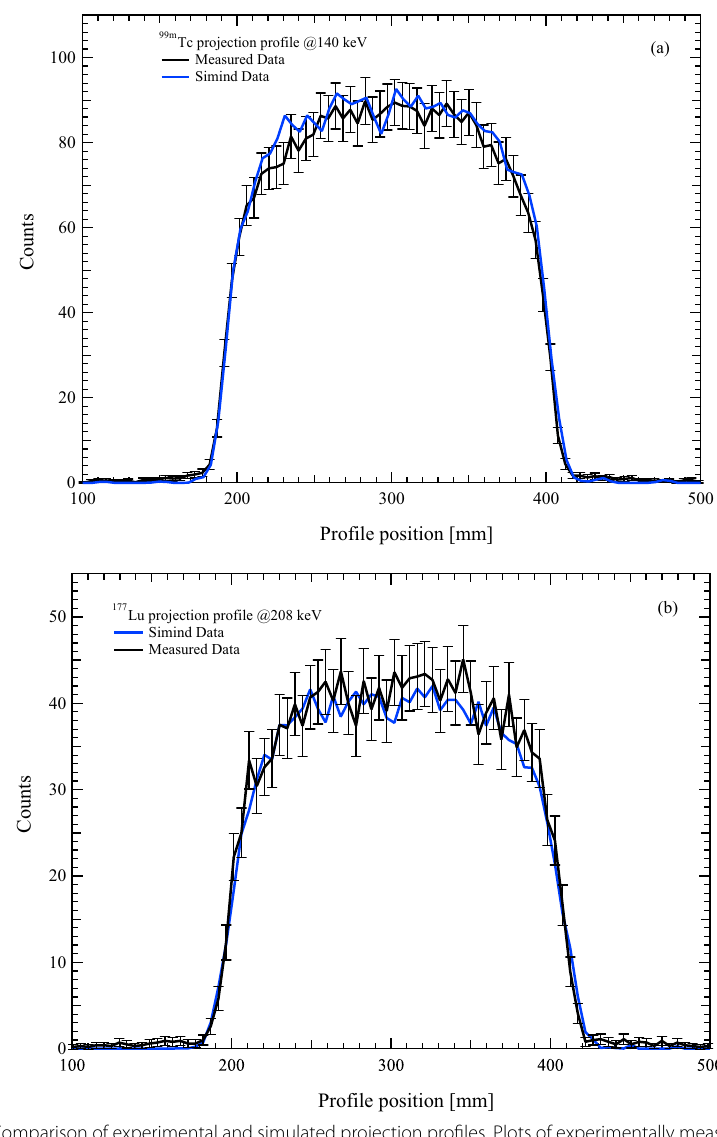
Fig. 4 Comparison of experimental and simulated projection profiles. Plots of experimentally measured and Monte Carlo simulated profile of uniform cylinder filled with a 99 m Tc and b 177